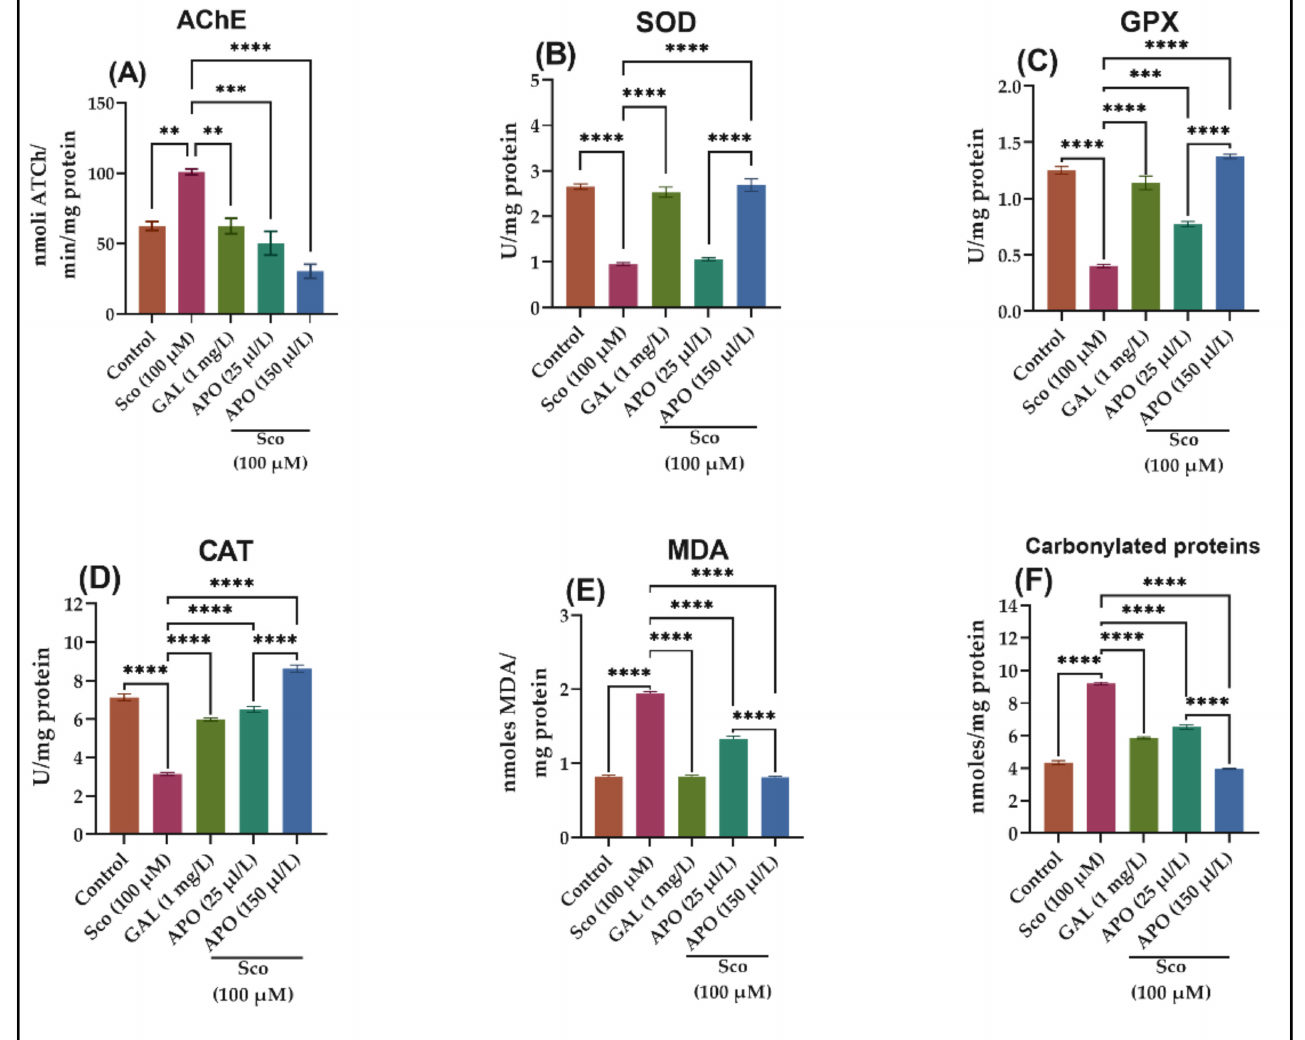
Figure 4. Effects of Angelica purpurascens essential oil (APO: 25 and 150 µ L/L) on ( A ) AChE; ( B ) Super- oxide dismutase (SOD); ( C ) Glutathione peroxidase (GPX) and ( D ) catalase (CAT)-specific activities; ( E ) malondialdehyde (MDA); ( F ) carbonylated protein levels. Data are represented by means ± S.E.M. ( n = 10). ** p < 0.001, *** p < 0.0001, and **** p < 0.00001 (Tukey’s post hoc analyses). Galantamine (GAL, 1 mg/L) was used as reference positive